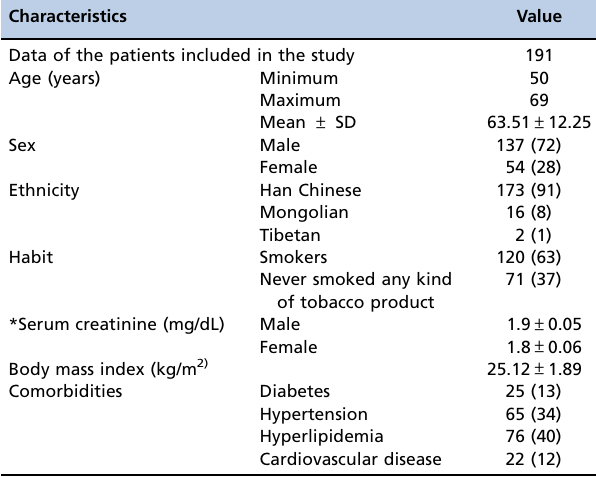
Table 2 - Anthropological, demographic, and clinical characteristics of the enrolled